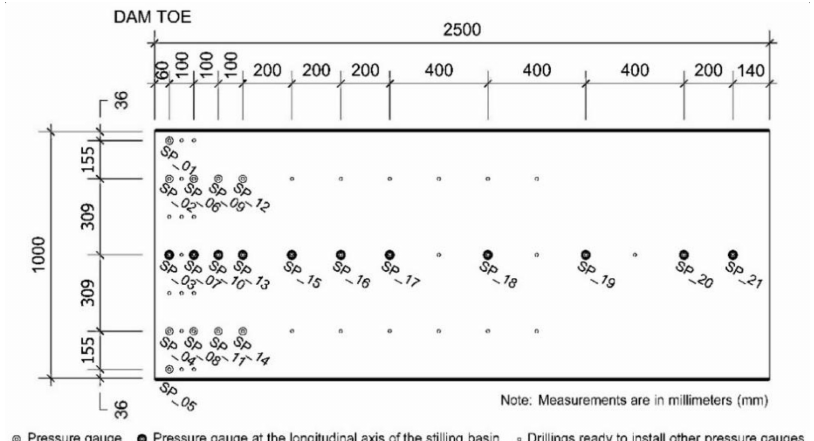
Figure 4. Plan view of the location of the dynamic pressure devices at the bottom of the stilling basin. The flow traveled from left to right, being the left border of the dam